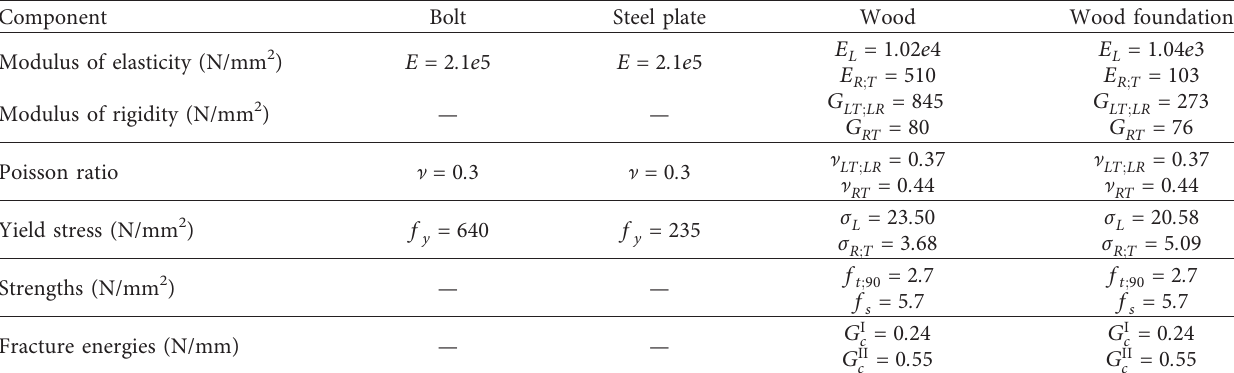
Table 1: Material constants applied in this